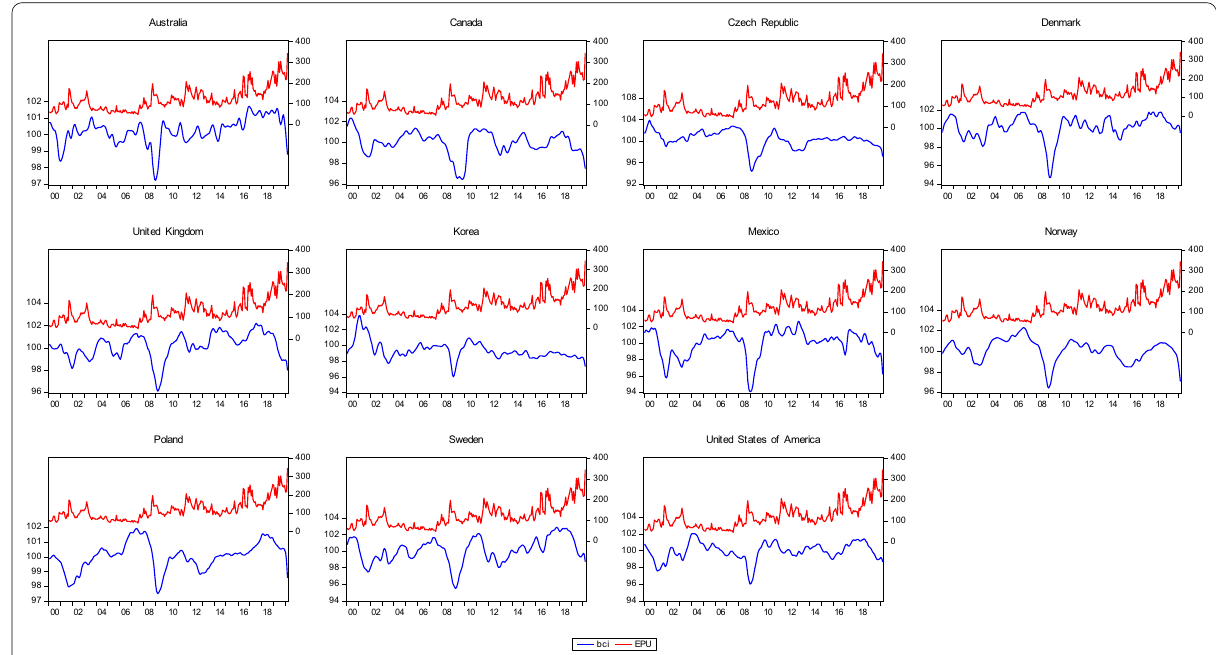
Fig. 4 Trends in business confidence and economic policy uncertainty in the non-Eurozone countries